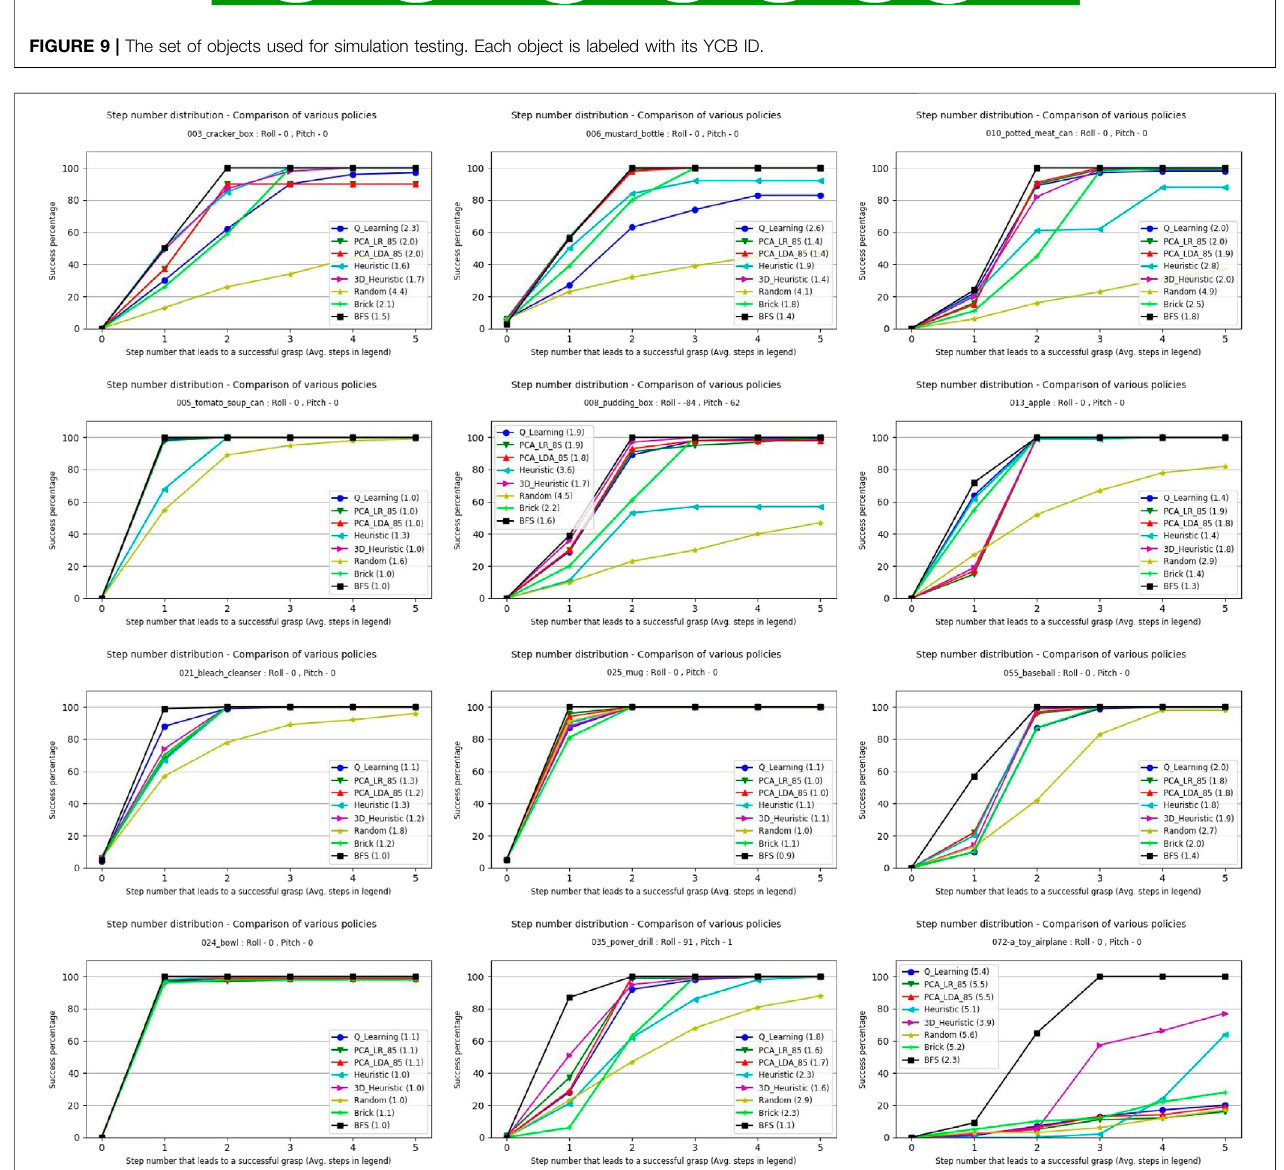
FIGURE10| Simulation results forapplyingeach approach toeach object in100pre-set poses. Success isde fi ned asreaching aviewcontainingagrasp above a user de fi ned threshold. The number in parenthesisby the policy names in the legend is the average number of steps that policy took to fi nd a grasp. For cases where no grasp was found, the step count was considered to be